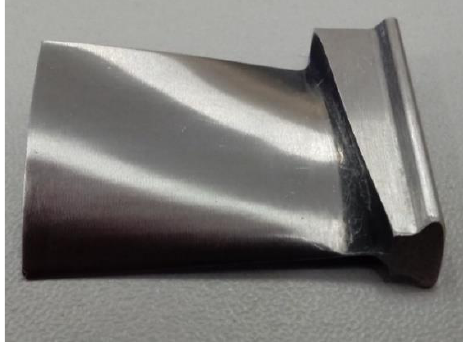
Figure 17. View of the blade after grinding.